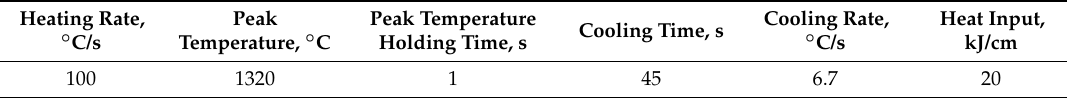
Table 2. Single-pass welding thermal simulation